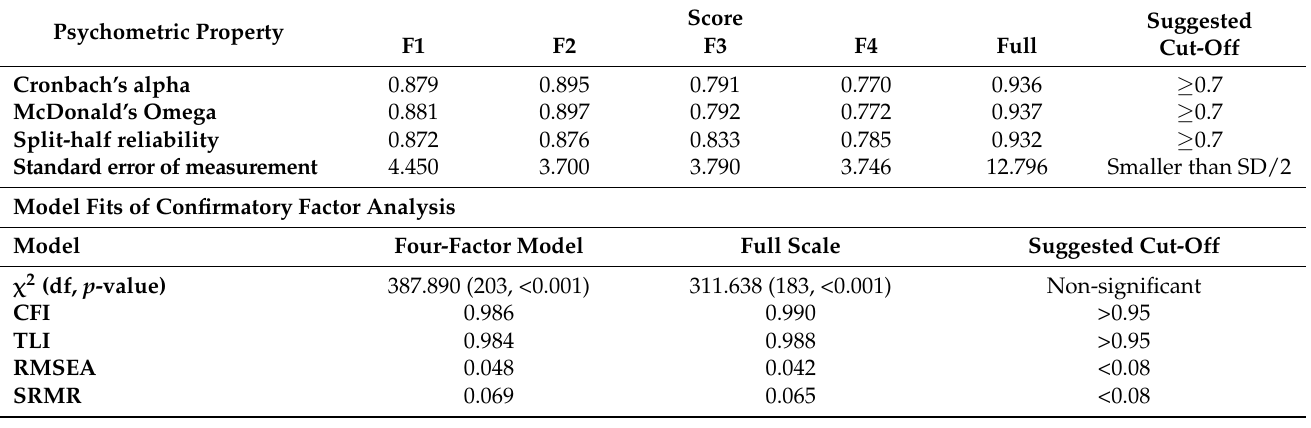
Table 3. Scale-level psychometric properties of the Korean version of the PANSAM